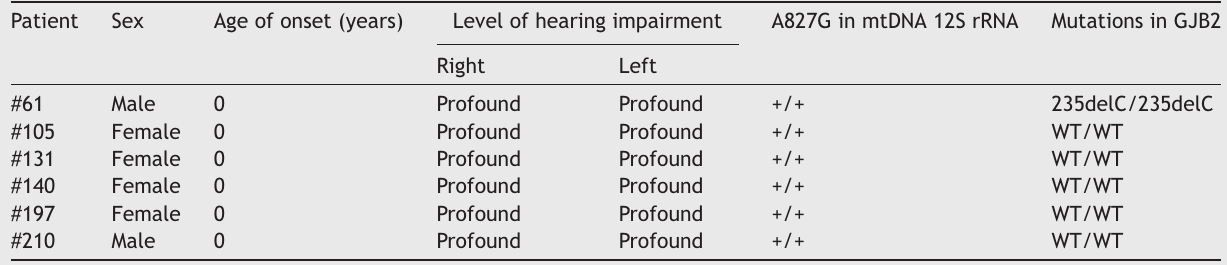
Clinical and genetic characteristics of six patients carrying A827G in mtDNA 12S